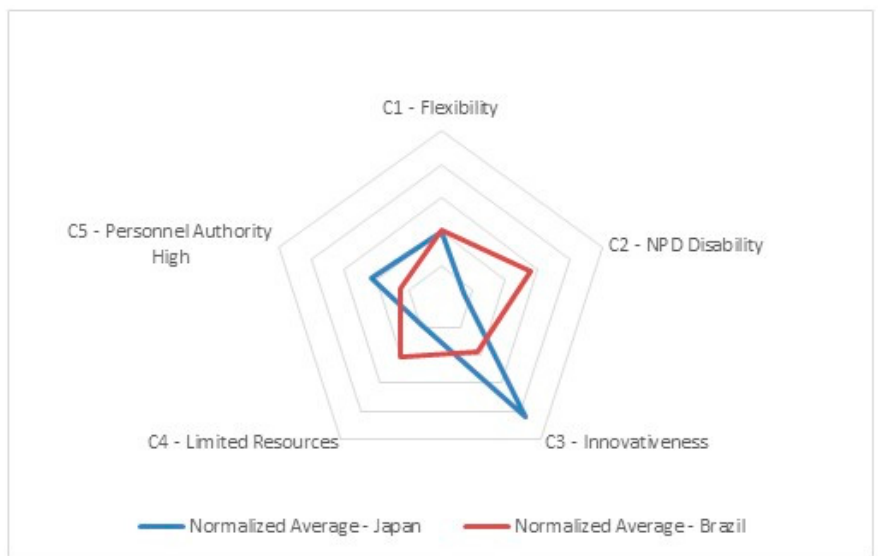
Figure 2. Comparison of the weights assigned to the criteria in the AHP method.